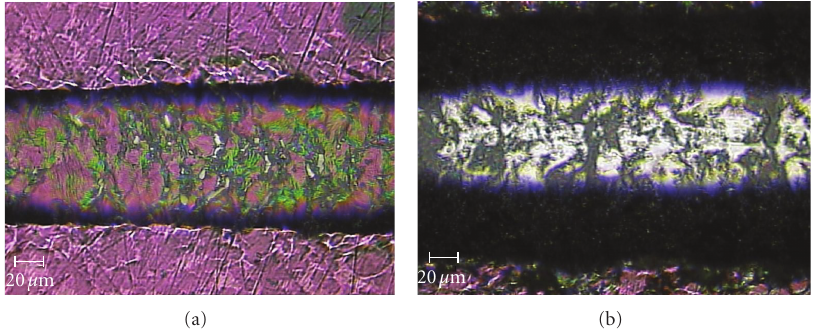
Figure 8: Scratch test for NbN coating (deposited at N 2 /Ar flow = 20%) on MS at (a) 9N load, showing chipping and cracks and (b) 28N load, showing nearly complete delamination.